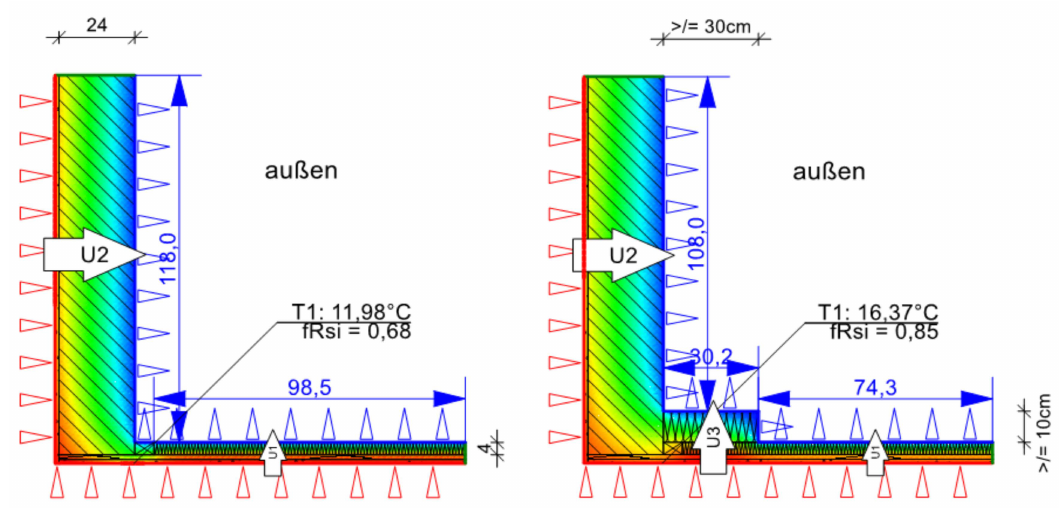
Figure A28. Before and after the thermal bridge retrofit of a connection between a rooftop and a wall (created with ThermCad thermal bridge simulation